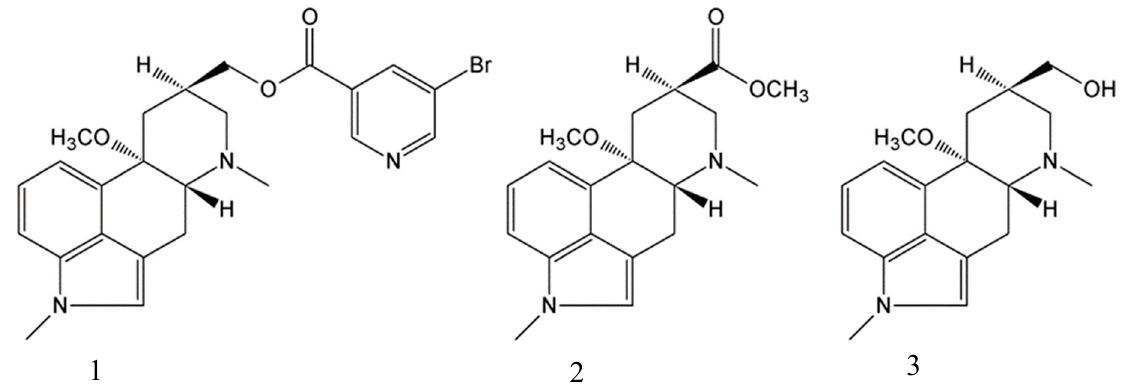
Figure 1. Scheme of nicergoline ( 1 ), ester ( 2 ), and alcohol ( 3 -MeLuol) intermediates.